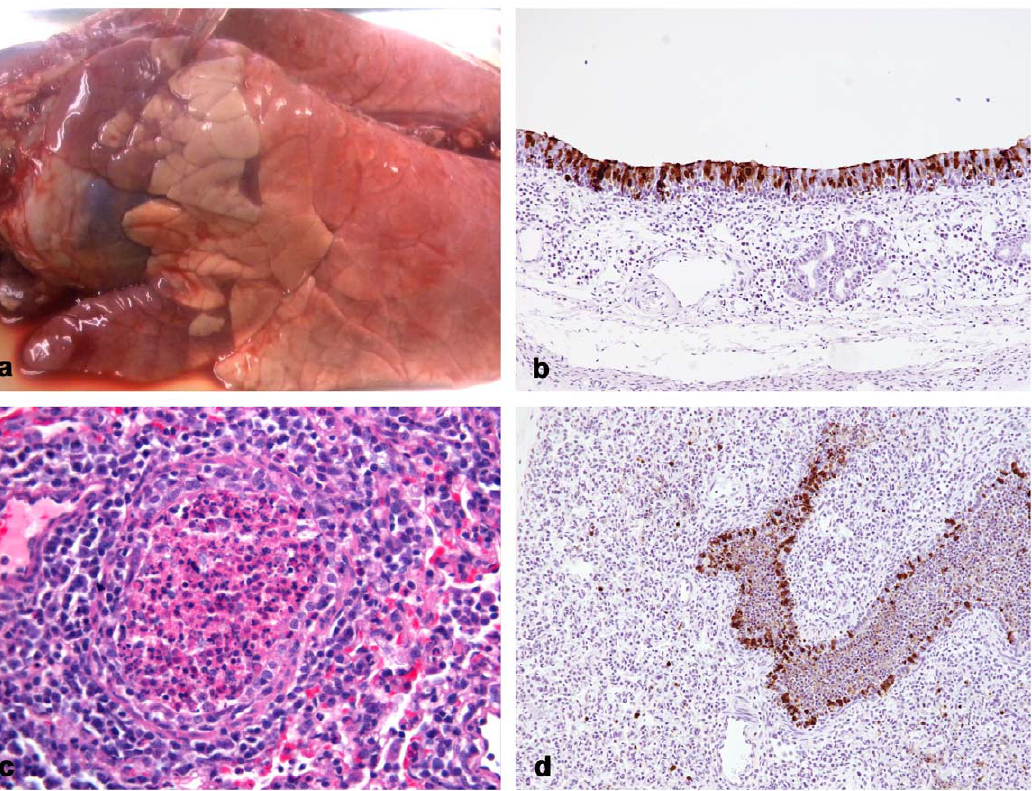
Figure 2. Pathological changes (a,c) and immunohistochemical detection of viral antigen. a . Lung. In-contact animal (TC4), 11 dpc. Multiple dark red areas of cranioventral pulmonary consolidation in the cranial and middle lung lobes. b . Nasal mucosa, 2 dpi. Influenza A nucleoprotein (brown) in numerous respiratory epithelial cells 20x. c . Lung, 7 dpi. Marked attenuation of bronchiolar epithelium due to epithelial cell necrosis, bronchiolar plug and peribronchiolar lymphohistiocytic infiltration. Haematoxylin and eosin 40x. d . Lung, 4 dpi. Viral nucleoprotein in abundant bronchiolar epithelial cells and cellular debris in the bronchiolar lumen and in several pulmonary alveolar macrophages 20x.